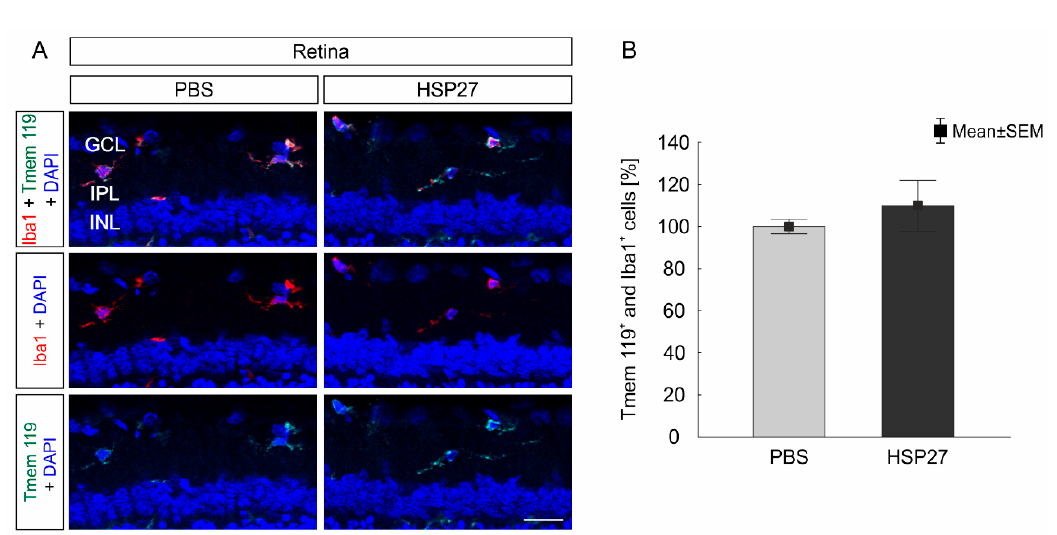
Figure 5. No microglia response in retina after HSP27 injection. ( A ) Antibodies against Iba1 (red) and transmembrane protein 119 (Tmem 119, green) were used to identify the retinal microglia population. The cell nuclei were stained with 4’,6-Diamidin-2-phenylindol (DAPI; blue). ( B ) The numbers of Tmem 119 + and Iba1 + cells were similar in the HSP27 group and the PBS group ( p = 0.4) GCL = ganglion cell layer, IPL = inner plexiform layer, INL = inner nuclear layer, scale bar = 20 μ m, n = 6/group.